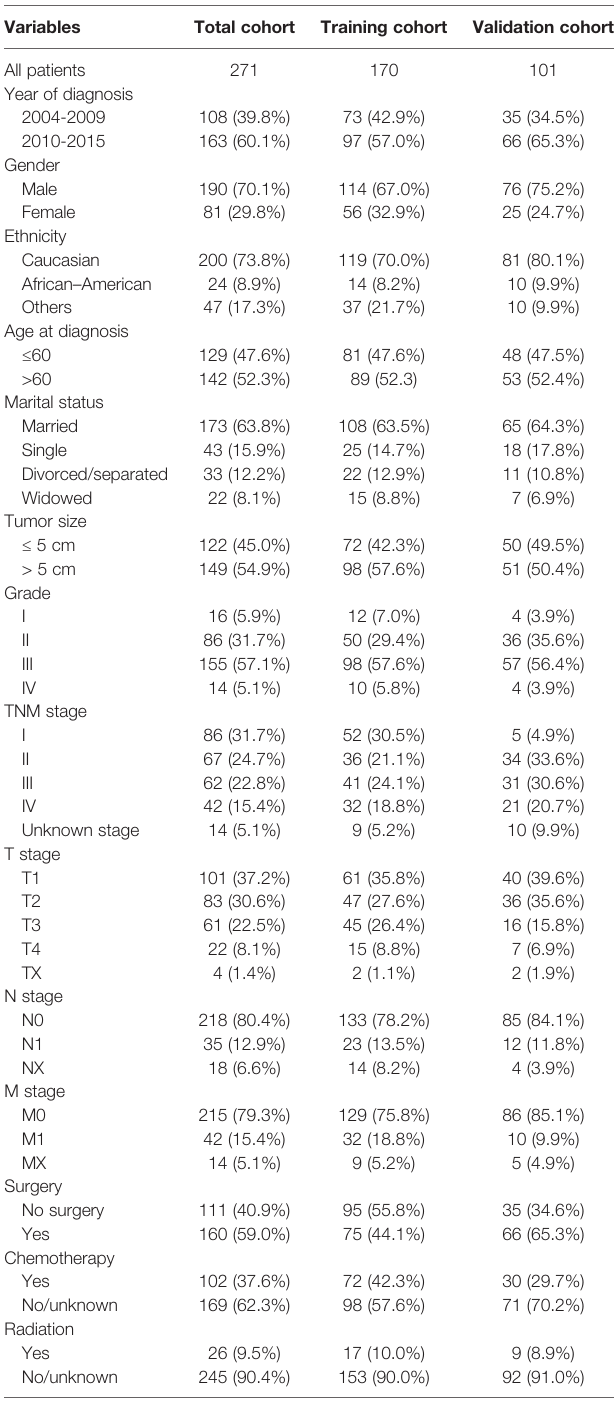
TABLE 1 | Demographic and clinicopathologic characteristics, and overall survival of patients with combined hepatocellular carcinoma and cholangiocarcinoma. Variables Total cohort Training cohort Validation